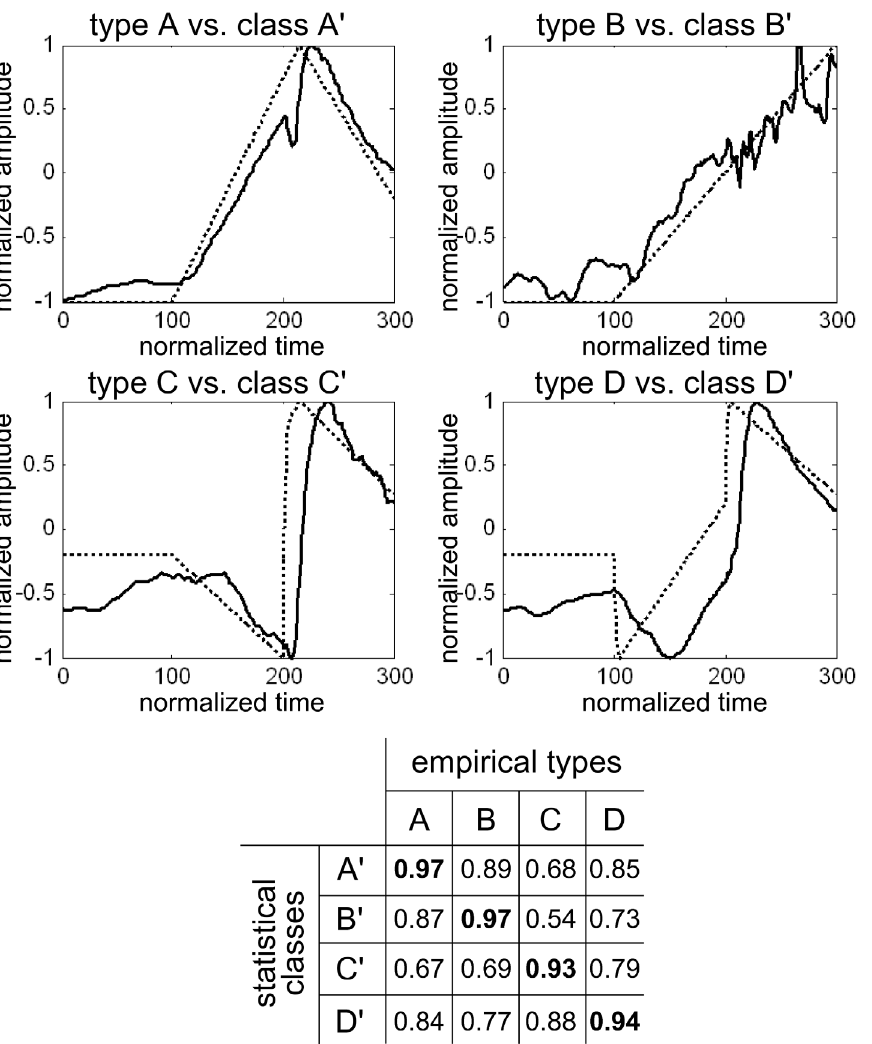
Figure 2. Comparison between the empirical models and the statistical models resulting from the clustering analysis. Empirical models are dotted lines, and statistical models are solid lines. In the figure, the exercise period is in gray. In the table, the highest coefficients are in bold characters.